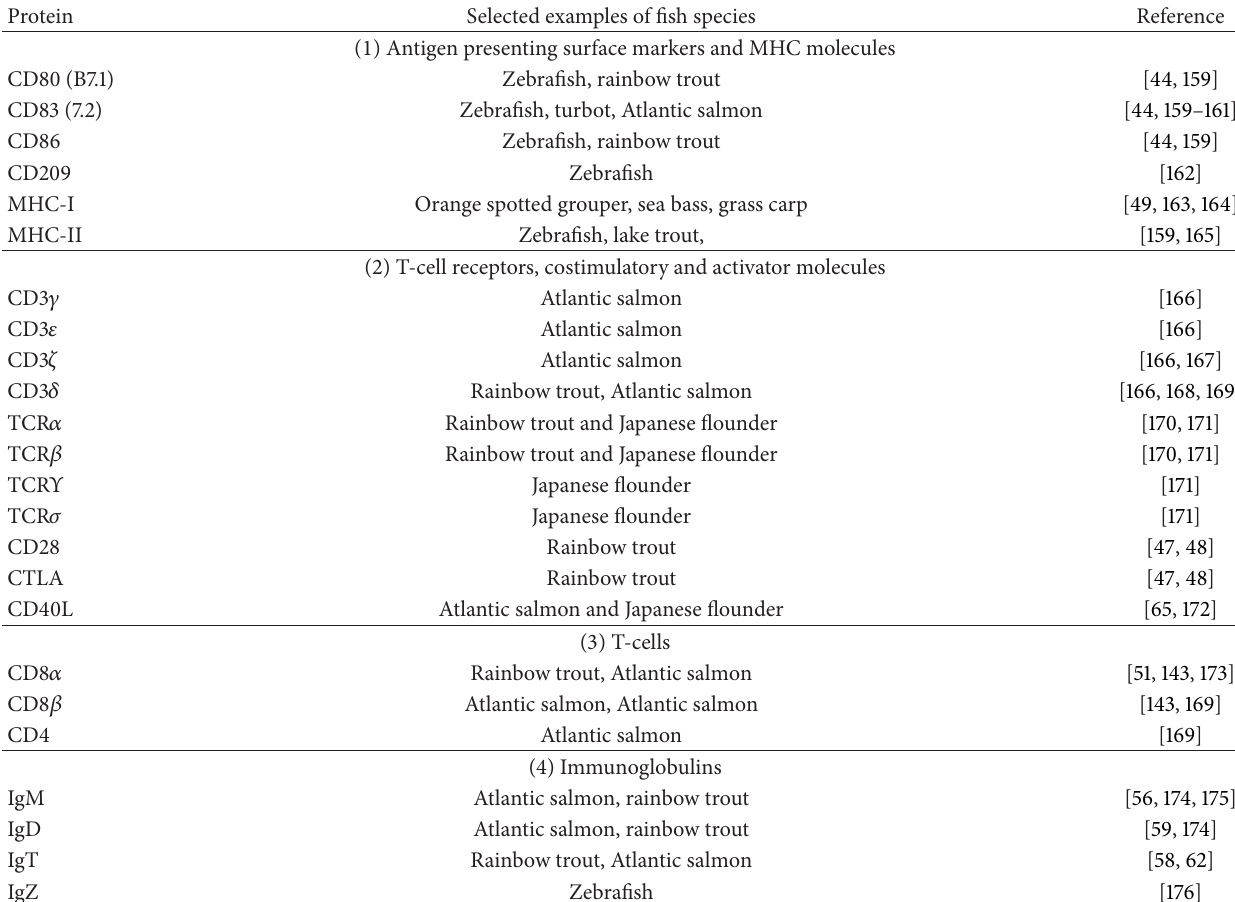
Table 1: Fish antigen presenting and adaptive immunity cell